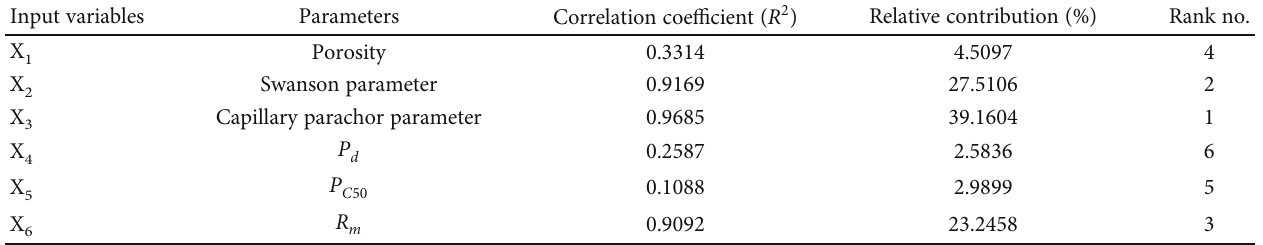
Table 2: Related e ff ort of every input in estimating the permeability according to the sensitivity analysis and correlation coe ffi cient notion. Input variables